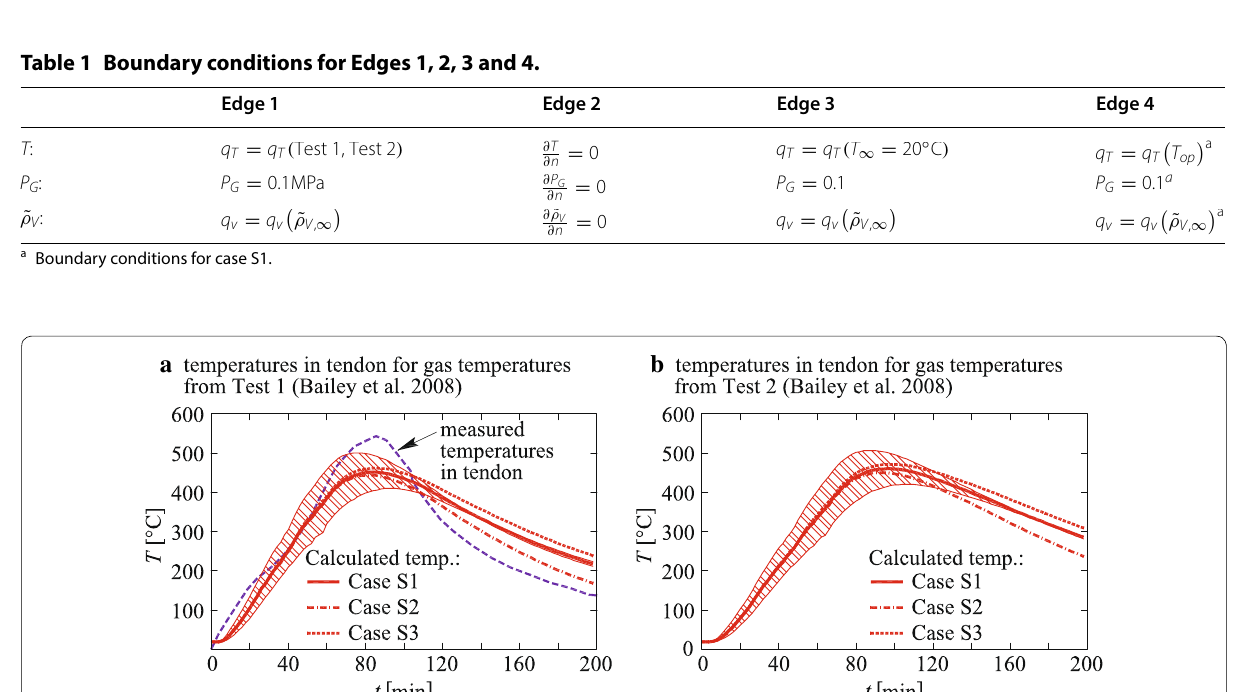
Table 1 Boundary conditions for Edges 1, 2, 3 and 4.